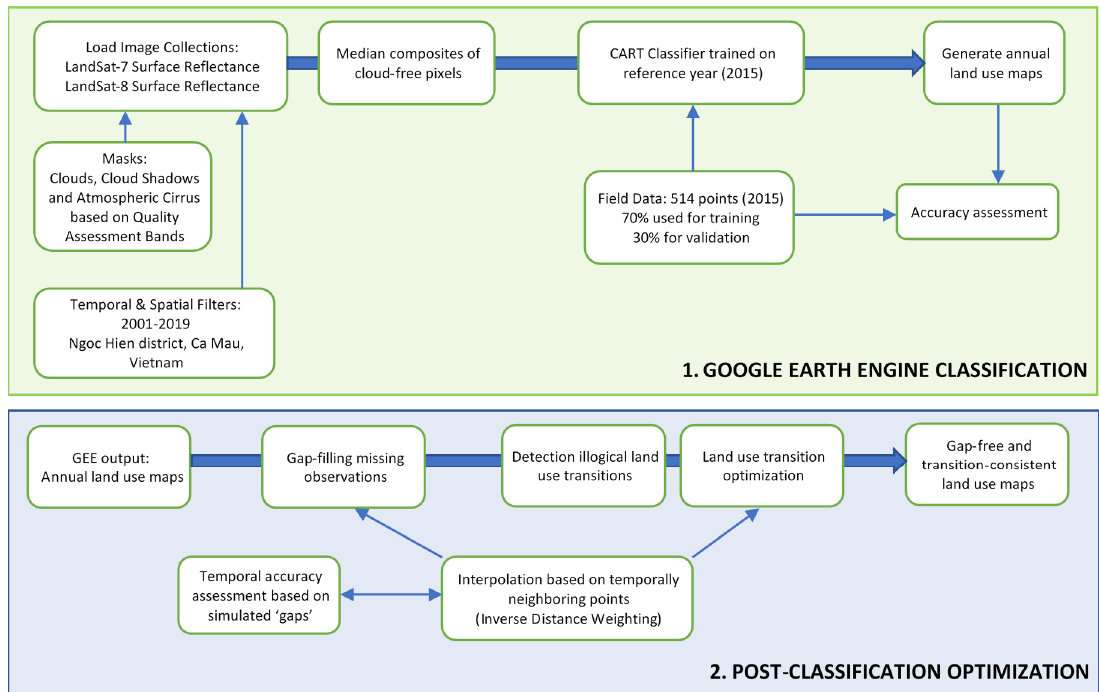
Figure 2. Data processing chain and workflow of the study separated in a repeated (1) GEE land use classification process and (2) post-classification optimization based on the temporal integration of land use classification output.